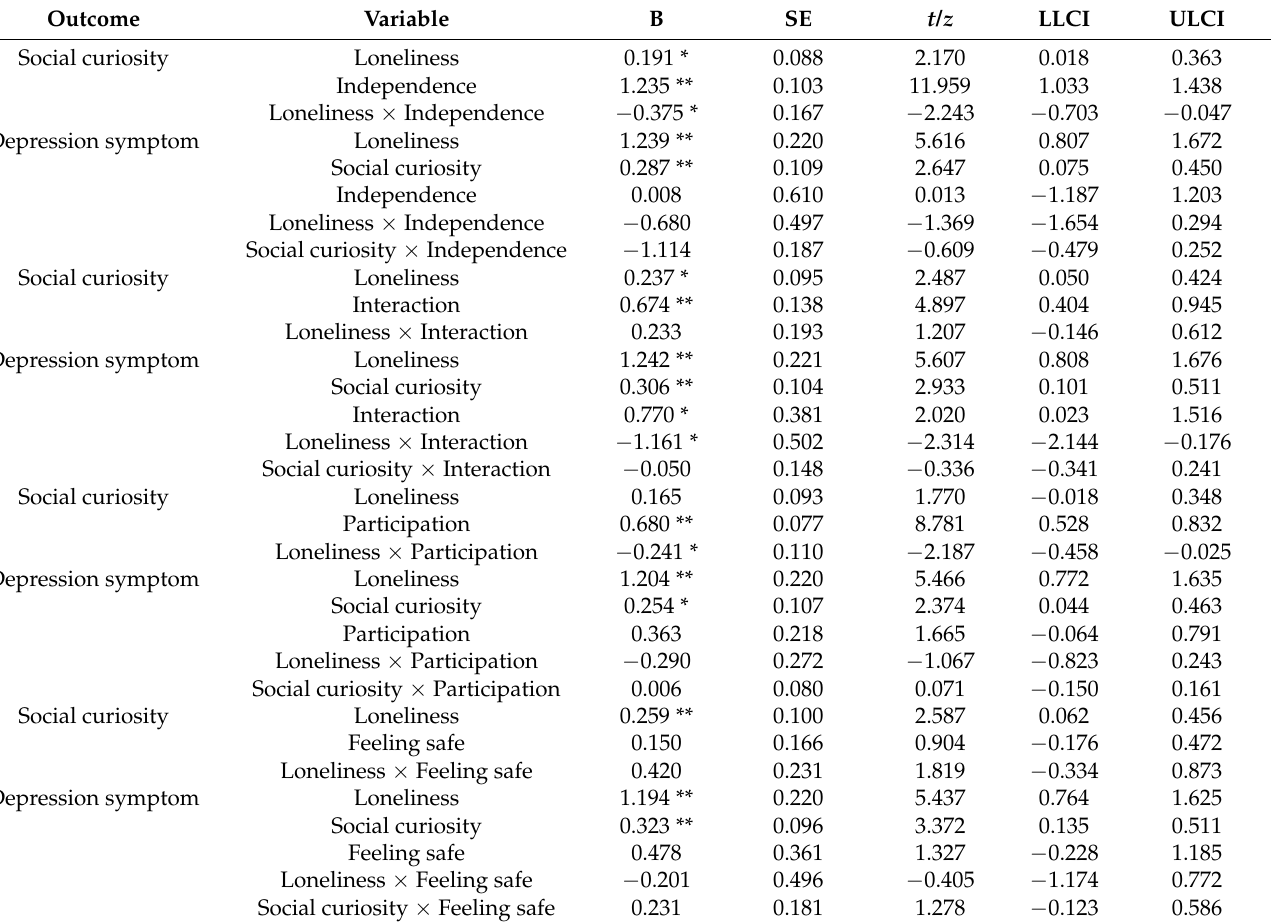
Table 4. Moderated mediation analysis (social curiosity, independence, interaction, participation, and feeling safe as